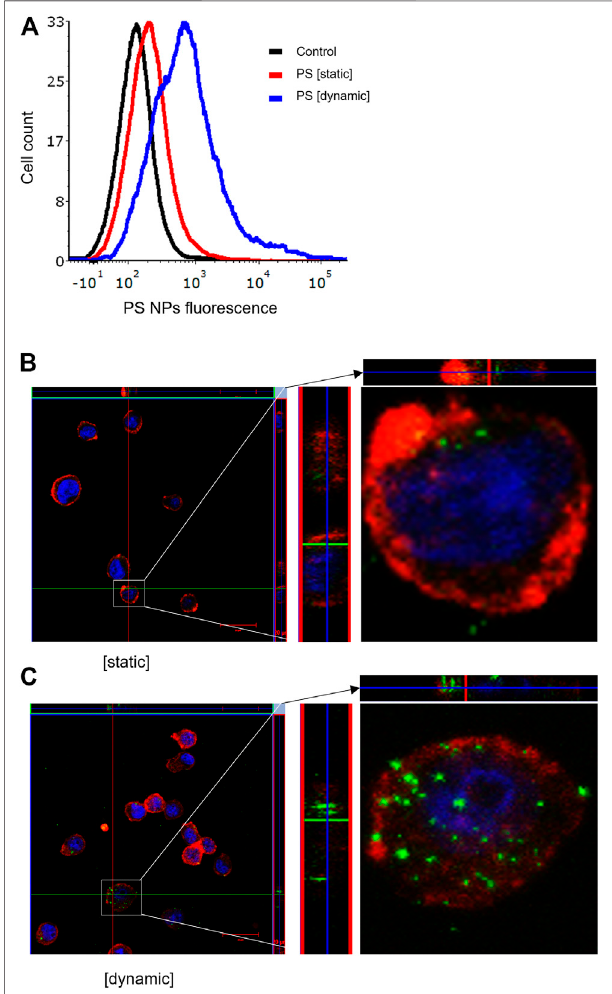
FIGURE4| Cellularuptakeof fl uorescentPSNPs(10 μ g/ml)understatic and dynamic exposure conditions. (A) Cellular uptake of PS NPs determined using fl ow cytometry after 2 h of exposure of BEAS-2B cells (B,C) Confocal microscopy of cells exposed for PS NPs after 1 h under static and dynamic exposures, respectively. The z-stack imaging con fi rmed the intracellularpresence oftheNPs. Cellsare counterstained using phalloidin red and DAPI (blue) to visualize the actin cytoskeleton and cell